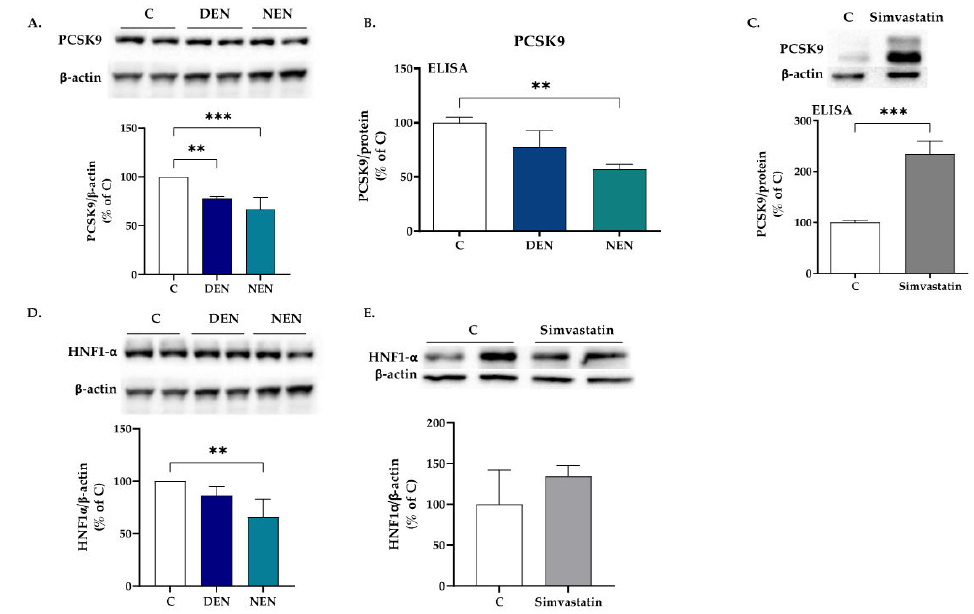
Figure 3. Impact of soy peptides on PCSK9 and HNF1 α protein expression. HepG2 cells were seeded in MEM 10% LPDS. After 48 h, the medium was replaced with MEM with 10% LPDS supplemented with YVVNPDN DEN (350 µ M) and YVVNPDN NEN (350 µ M). After 24 h, expression of PCSK9 ( A , B ) and HNF1 α was evaluated ( D ). HNF1 α protein expression upon 24-h treatment with 20 µ M simvastatin ( E ). β -actin was used as housekeeping protein. PCSK9 levels were assessed by ELISA (data were normalized for the total amount of proteins; panel ( B ). At least three independent experiments were conducted. ** p < 0.01 versus control (ANOVA); *** p < 0.001 versus control (ANOVA) ( A ); *** p < 0.001 versus control (Mann-Whitney) ( C ). LPDS, lipoprotein deprived serum. C, control (medium alone); DEN stands for YVVNPDN DEN ; NEN stands for YVVNPDN NEN